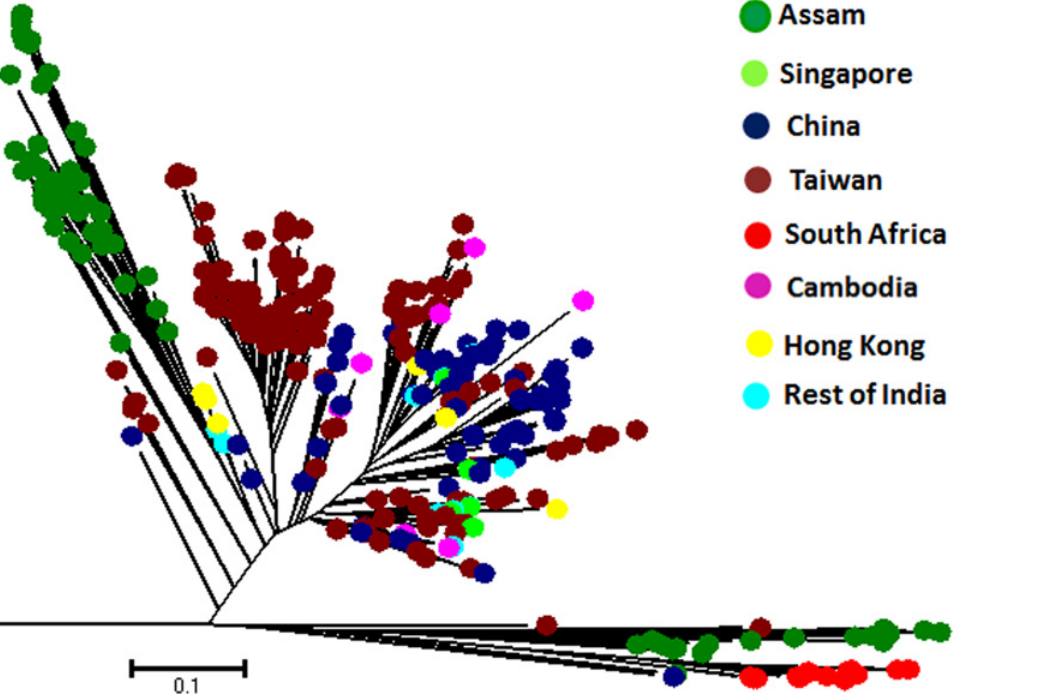
Fig 5. Comparison of Beijing MTBC isolates from Assam with Beijing isolates from other countries (Singapore, Cambodia, Hong Kong, China, Taiwan, South Africa and rest of India) where Beijing isolates are also reported. The radiation tree was constructed based on 24-MIRU-VNTR loci data using Neighbour-Joining method. Beijing isolates from Assam group into two well defined clusters, one major MTBC cluster which is close to some Beijing strains from Hong Kong, China, Taiwan and rest of India whereas the Beijing strains in the minor cluster were phylogenetically more close to a few Beijing strains from South Africa and